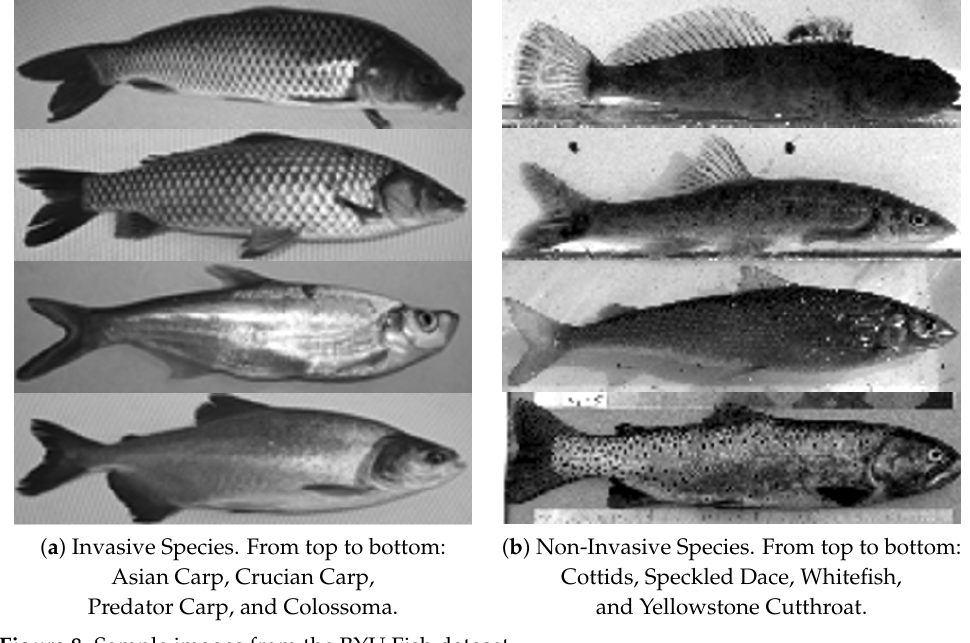
Figure 8. Sample images from the BYU Fish